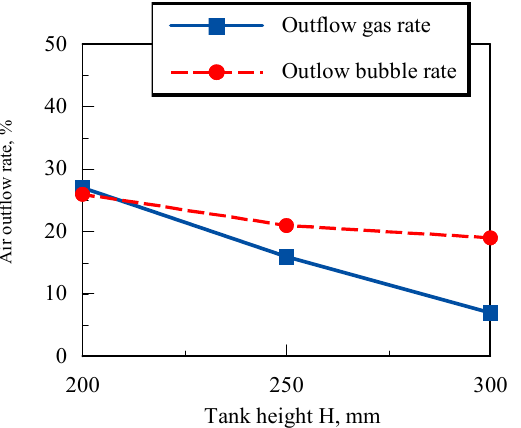
Figure 12. Relationship between tank height and maximum gas flow rate and bubble rate.